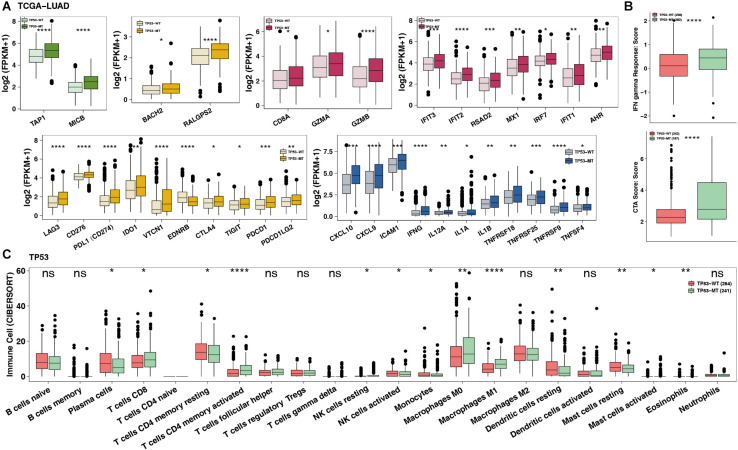
TP53 mutations mitigate immune resistance in LUAD. (A) The expression of immune-related genes (such as antigen presentation, B cells, cytolytic activity, immune inhibition, immune stimulation and IFN response) of TP53-mutated vs. TP53-wild type in TCGA-LUAD. (B) The immune score/signature of TP53-mutated vs. TP53-wild type in TCGA-LUAD. (C) The contents of immune cells of TP53-mutated vs. TP53-wild type in TCGA-LUAD using CIBERSORT analysis. ****P < 0.0001, ***P < 0.001, **P < 0.01, *P < 0.05.